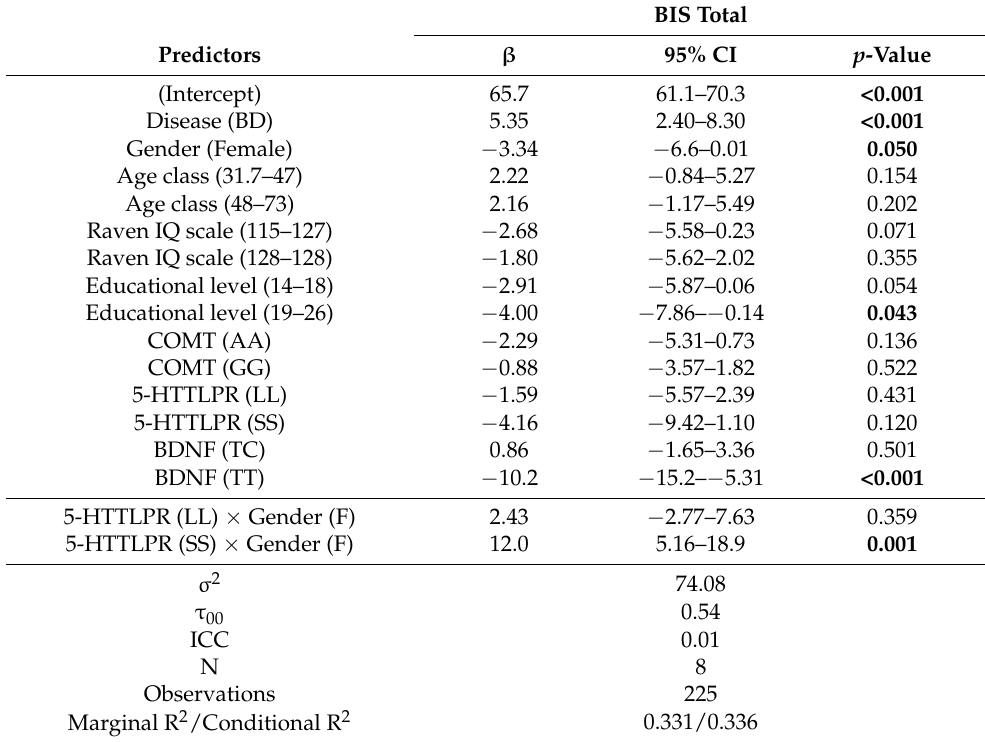
Table 3. Coefficients ( β ) estimated by the mixed-effects regression model considering the Total BIS score as dependent